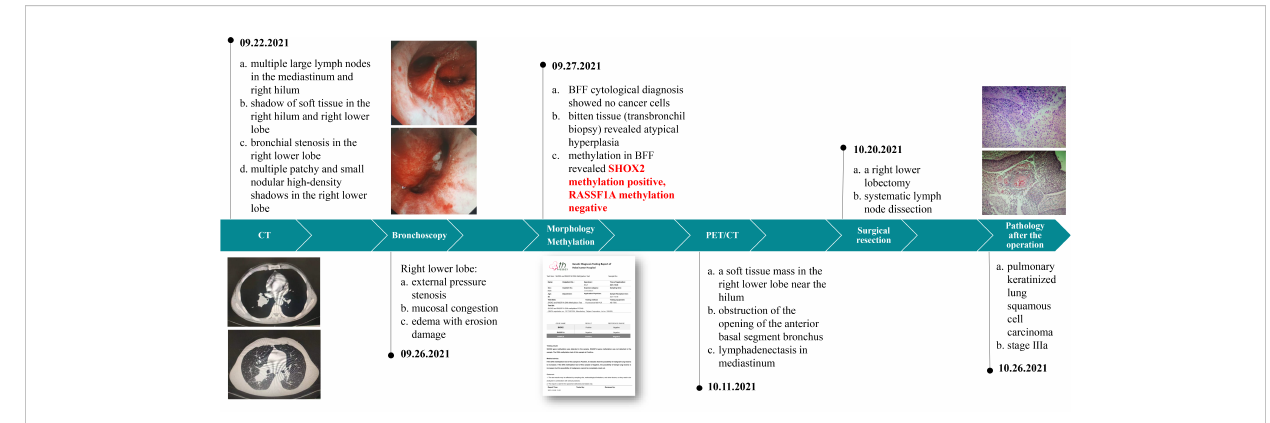
FIGURE 4 Patient medical history.